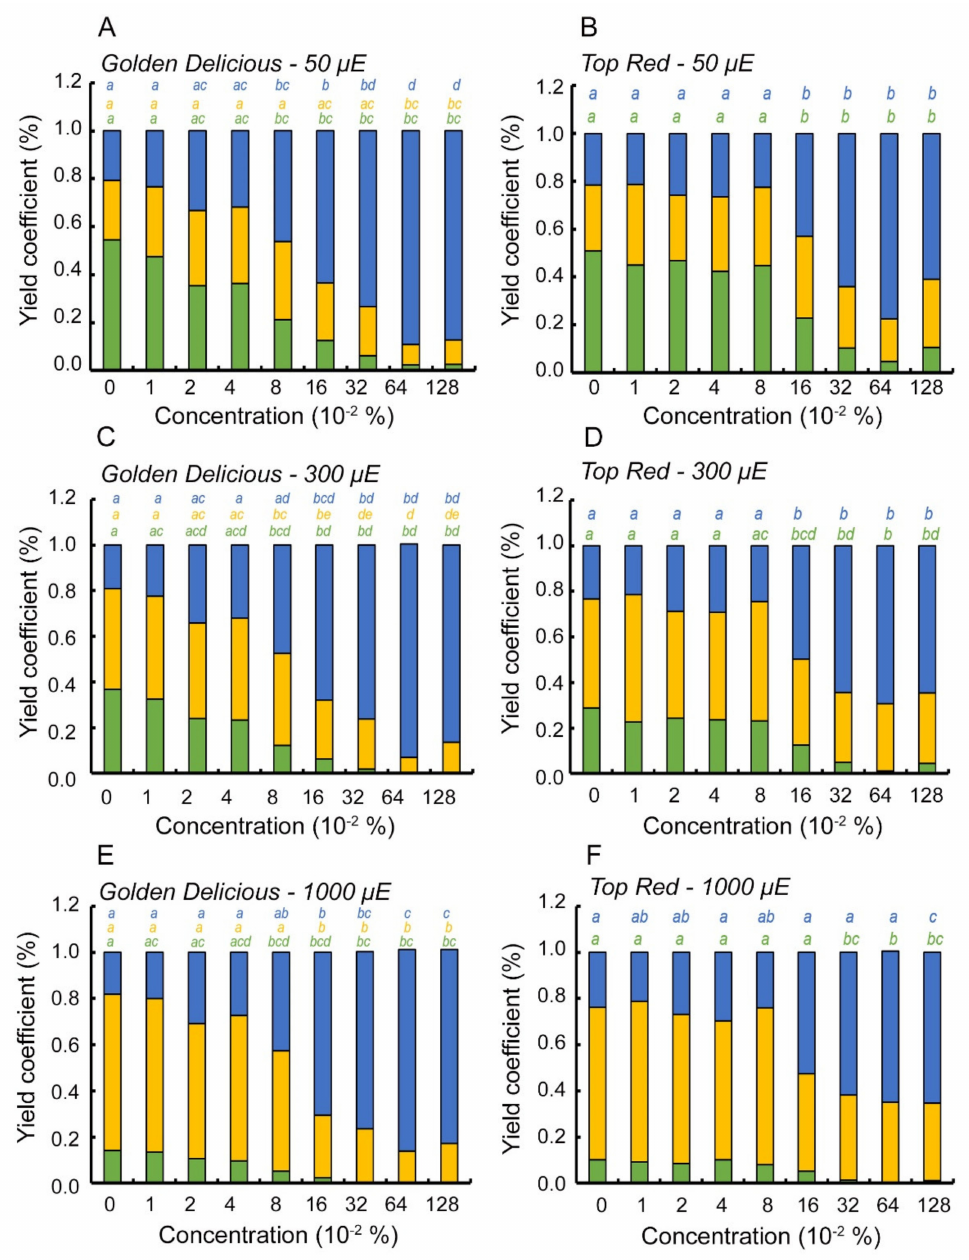
Figure 3. Quantum yields of absorbed energy distribution between the three outcomes of light energy utilization in two apple cultivars with Brevis ® inhibitor. Panels ( A , C , E ) and ( B , D , F ) represent results of light energy utilization distribution analysis across three light intensities extracted from the light response curve, for Golden Delicious and Top Red cultivars, respectively. Each column comprises three stacked bars which are summed to 1. The colors green, yellow and blue represent effective quantum yield of PSII photochemistry ( Φ PSII ), quantum yield of regulated non-photochemical energy loss in PSII ( Φ NPQ ) and quantum yield of non-regulated energy loss in PSII ( Φ NO ), respectively. Each bar represents three biological repeats. Letter notations describe statistically significant differences ( p < 0.05). µ E is µ mol photon m − 2 s − 1